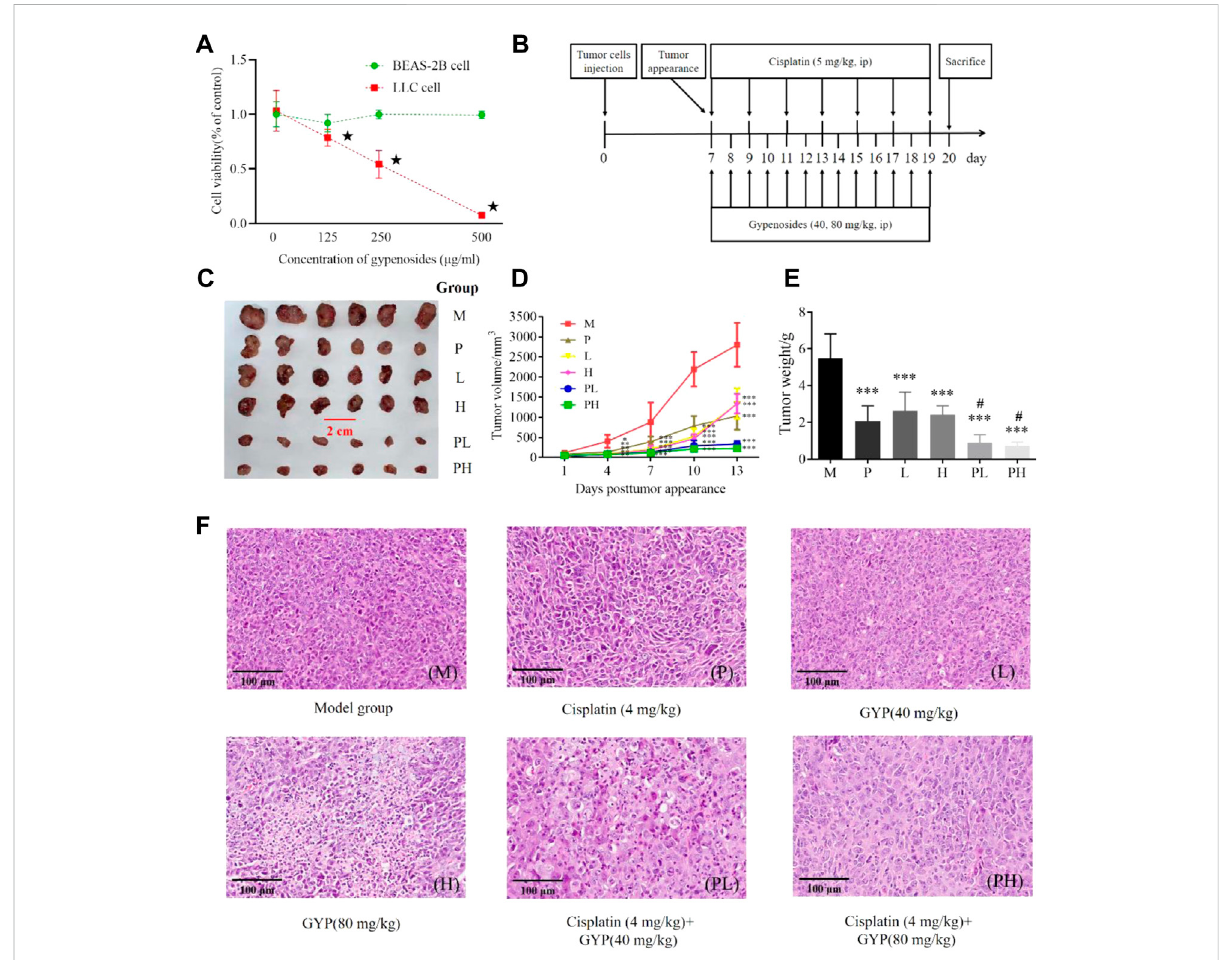
FIGURE 2 GYP suppressed the growth of xenografted LLC tumors and enhanced cisplatin ef fi cacy in C57BL/6 mice. The cell viability of GYP against LLC cells and BEAS-2B cells, vs. 0 mg/ml GYP, + p < 0.001 (A) ; Administration procedures in animal experiment (B) ; Tumor visualization of 6 groups (C) ; The tumor volumes (D) and tumor weights (E) of 6 tumor-bearing group (M: model group, P: cisplatin group, L: low-dose GYP group, H: high-dose GYPgroup, PL: cisplatin + low-doseGYPgroup, PH:cisplatin+ high-dose GYP group;vs. Controlgroup, * p < 0.05, ** p < 0.01, *** p < 0.001; vs. Model group, # p < 0.05); The histopathology sections (H&E, magni fi cation = ×40, 50 μ m) of tumor of 6 groups